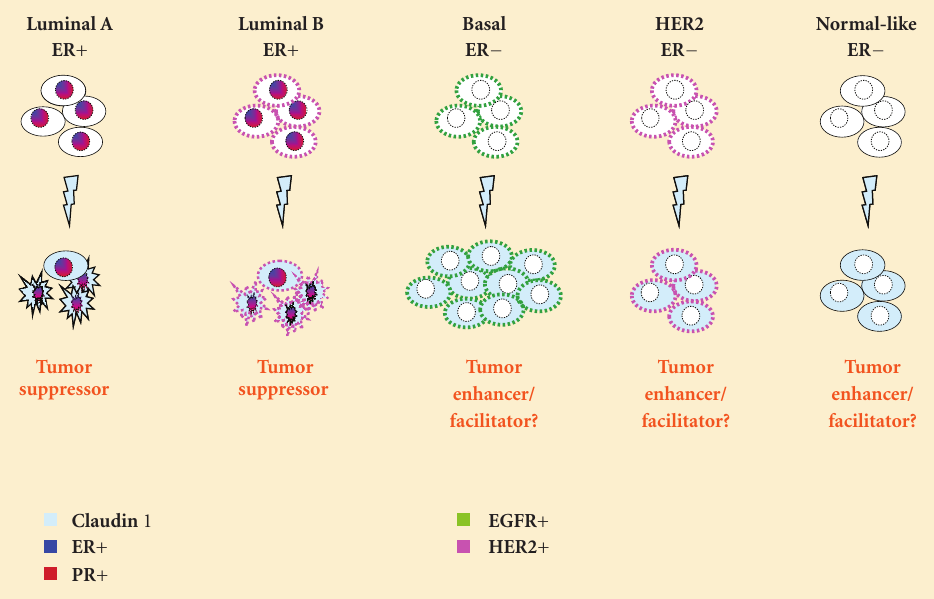
Figure 3: A hypothetical model of claudin 1 expression in di ff erent breast cancer subtypes. This model proposes that claudin 1 is a tumor suppressor in the ER+ve subtypes of breast cancer (luminal A and B) and a tumor enhancer/facilitator in the ER − ve subtypes (basal-like, Her2 over expressing, normal-like). Whereas a significant association between claudin 1 and the basal-like subtype has been demonstrated, this is yet to be determined for the Her2 over expressing and the normal-like